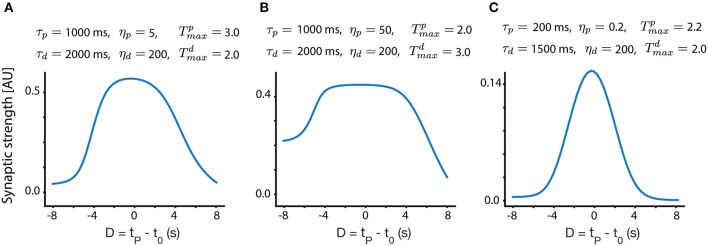
Fixed point place field structure. (A–C) Fixed point weights as a function of D for different sets of parameters. The velocity in all these subplots is identical (v = 0.116 m/s, chosen to match the velocity in Milstein et al., 2020), and the same presynaptic Gaussian place field is used, with a SD width of 0.21 m. All other parameters are indicated above each subplot.